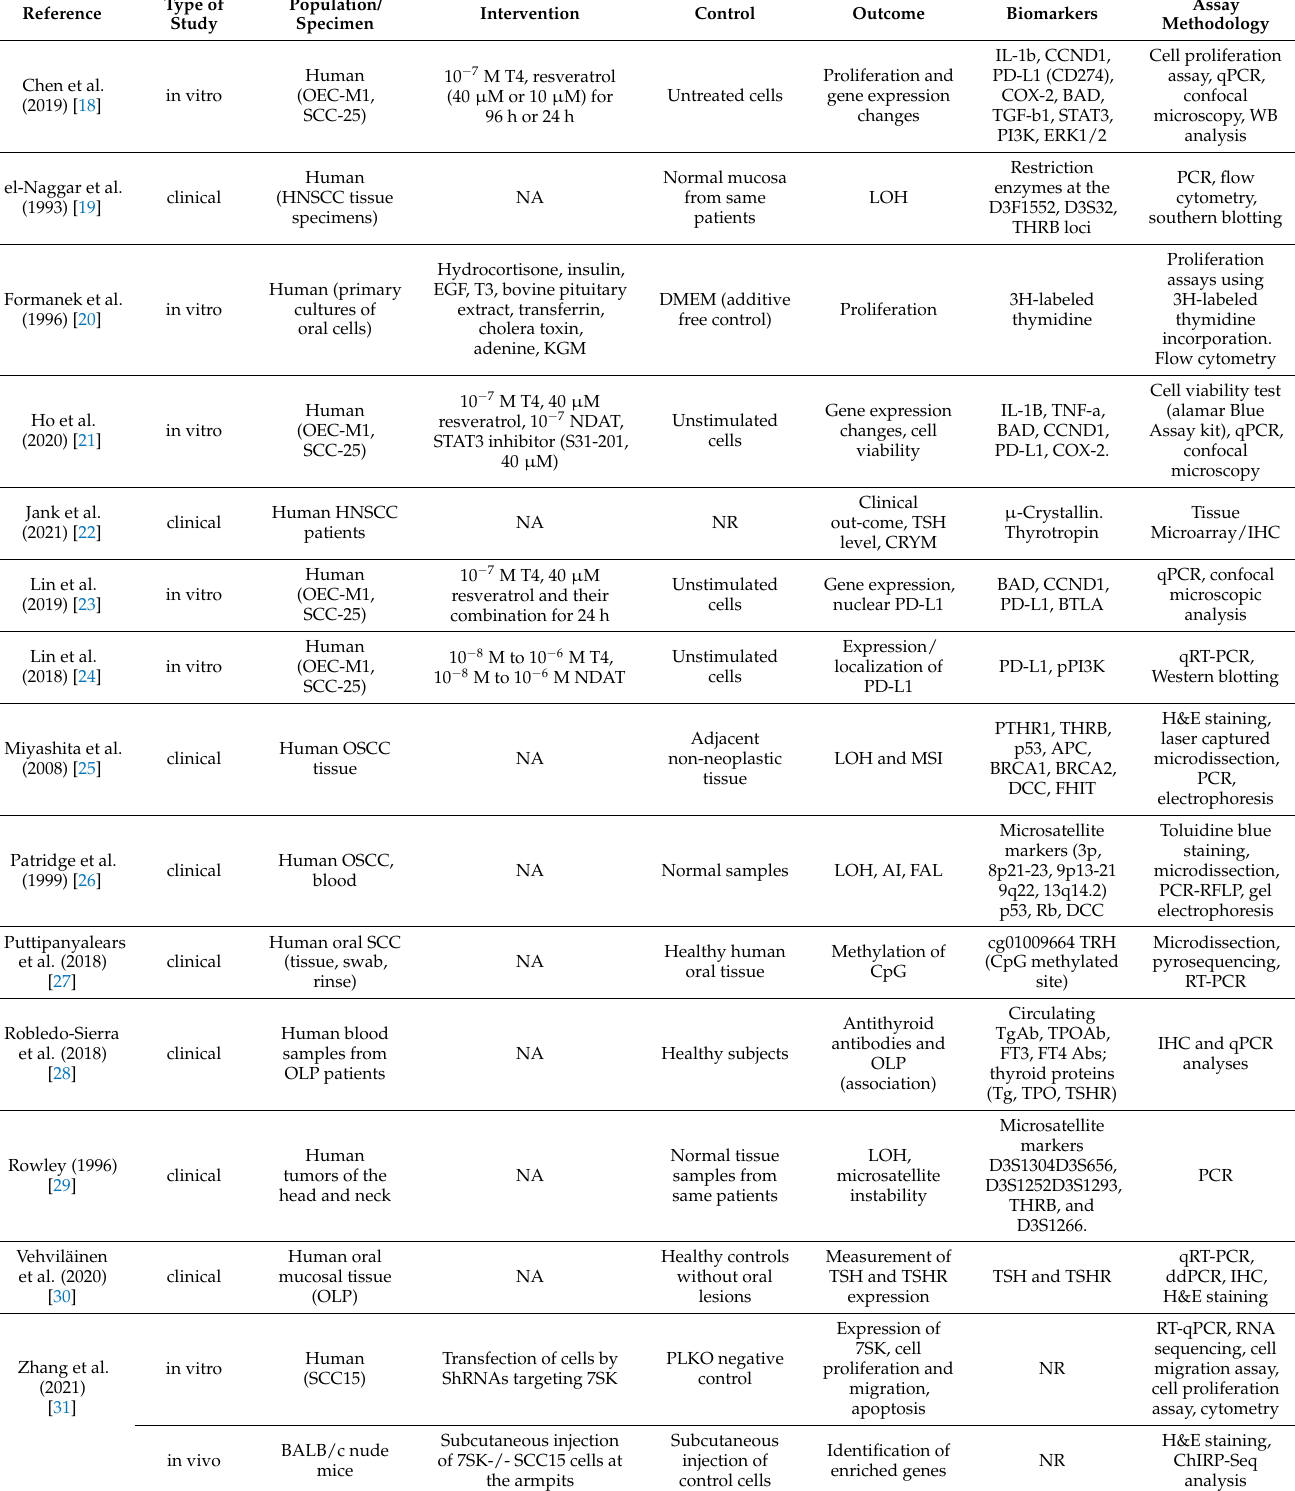
Table 1. Characteristics of included